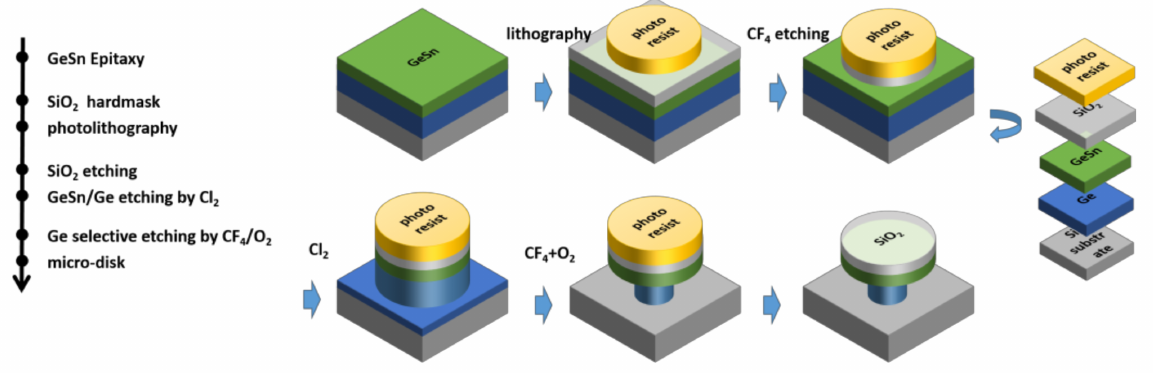
Figure 1. Formation of partial strain-relaxed GeSn micro-disk with SiO 2 as hard mask: process flow